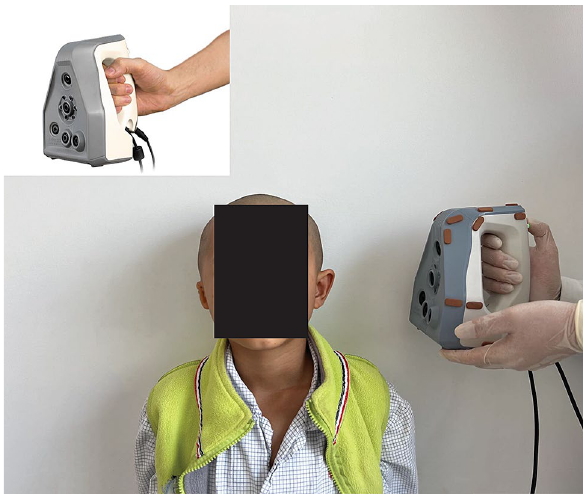
Figure 4. Method and devices of auricle scanning.